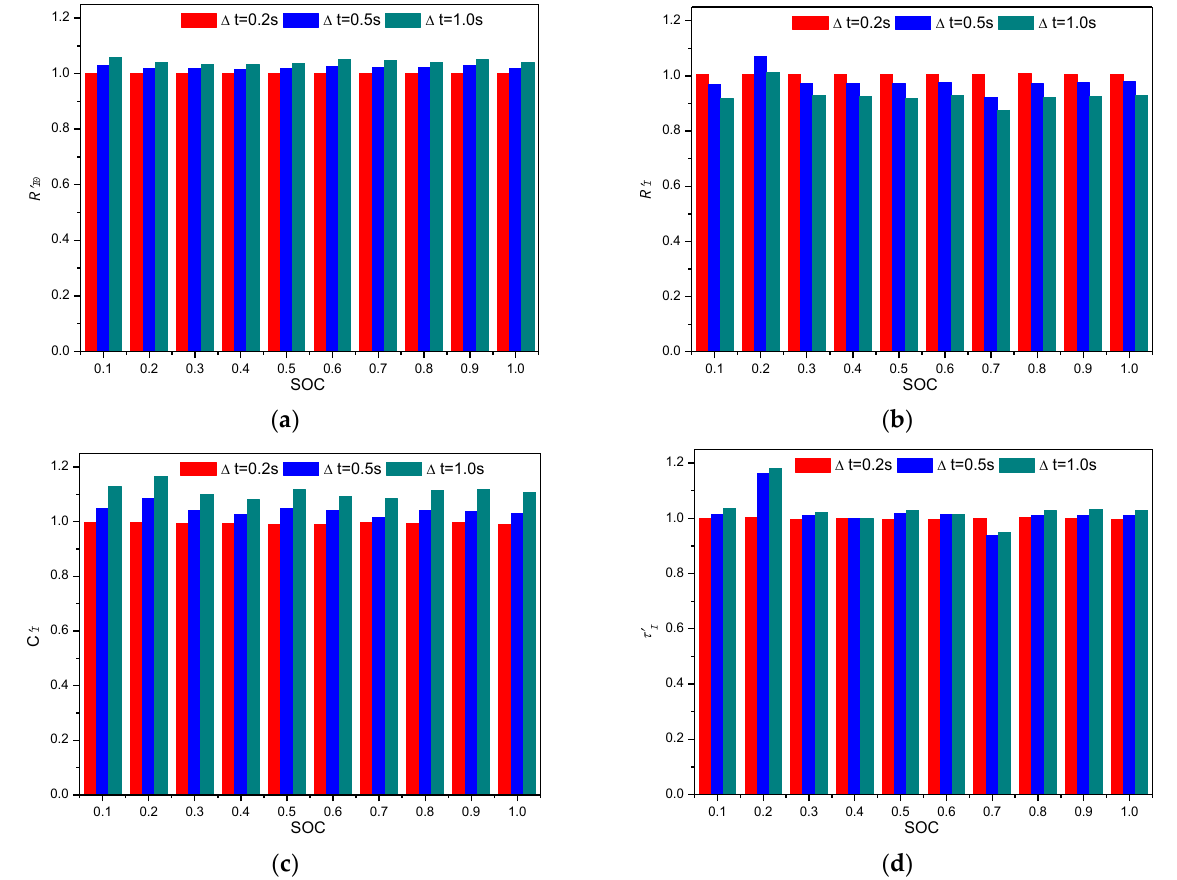
Figure 13. Change curves of non-dimensional parameters with SOC of 1-RC circuit model: ( a ) R (cid:48) I0 ; ( b ) R (cid:48) I ; ( c ) C (cid:48) I ; ( d ) τ (cid:48) I .